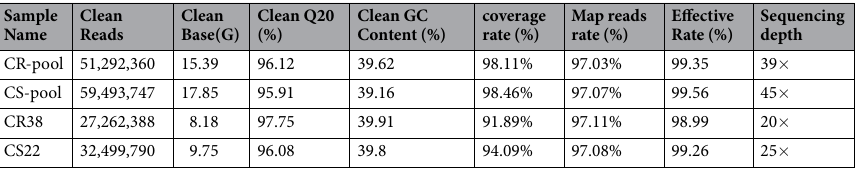
Table 2. Summary of BSA sequencing data for each